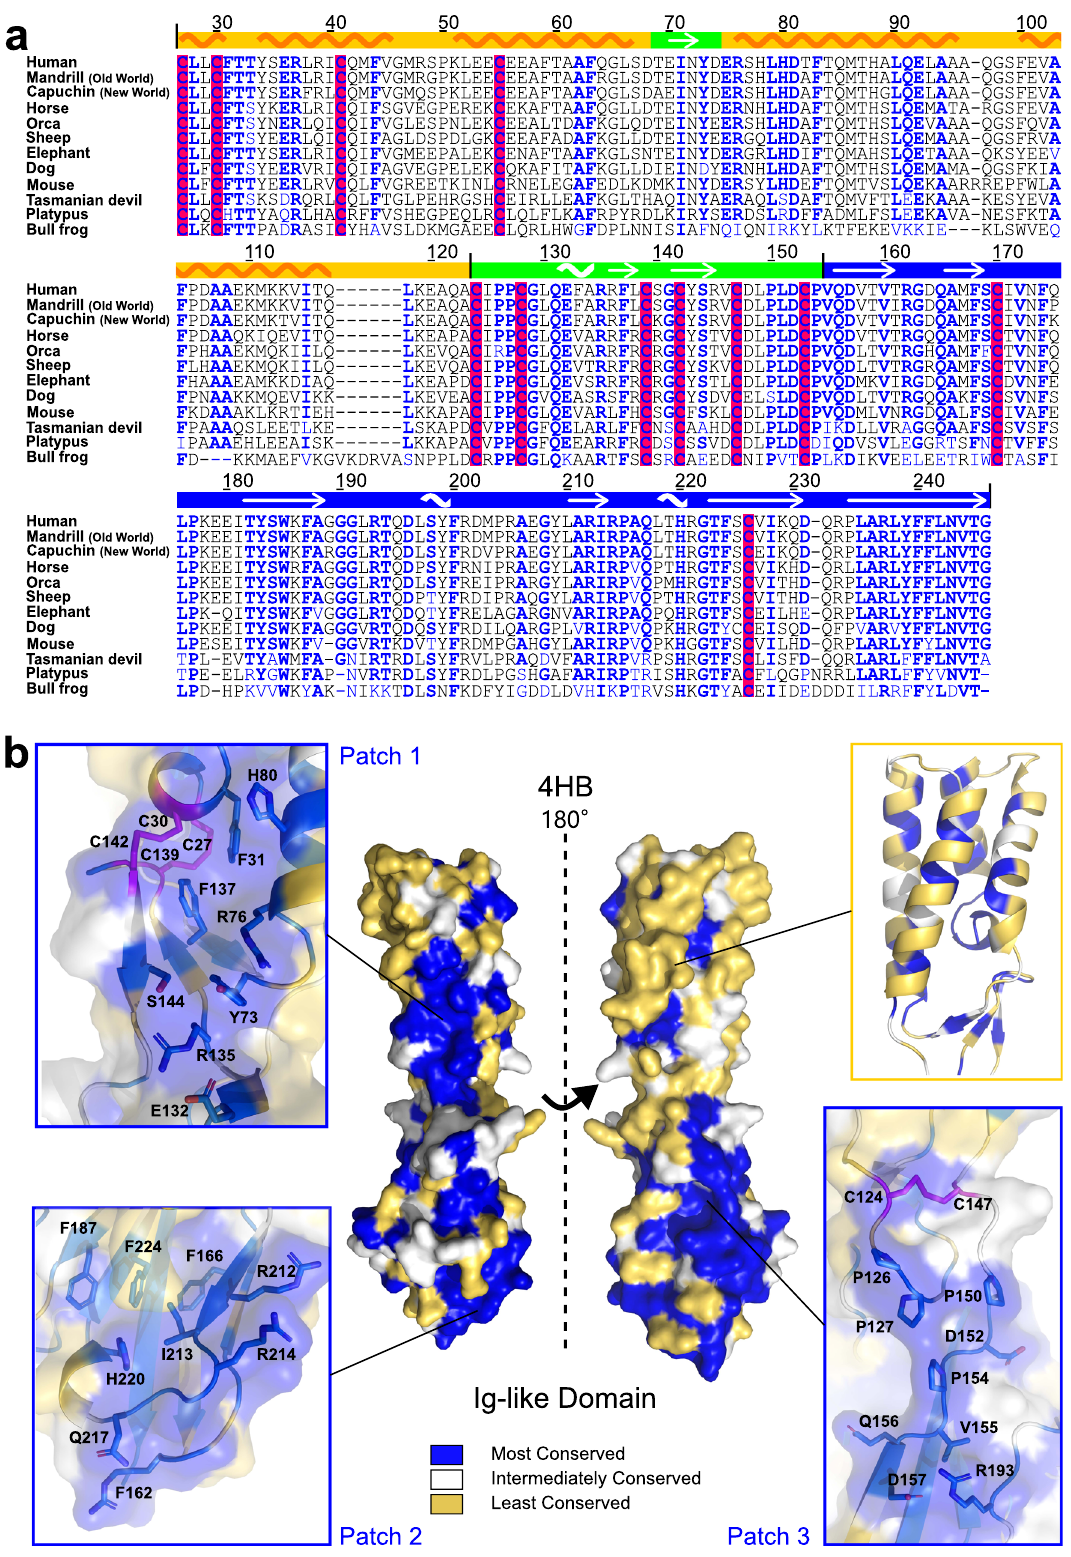
β -sandwich serves a conserved purpose. Yet, despite the extensive hydrogen bonding and electrostatic networks within the hinge regions of both SPACA6 and IZUMO1, evidence of inherent fl exibility can be seen in an alignment of the multiple solved IZUMO1 structures 37,43,44 . Alignments of the individual domains overlap well, but the orientation of the domains relative to each